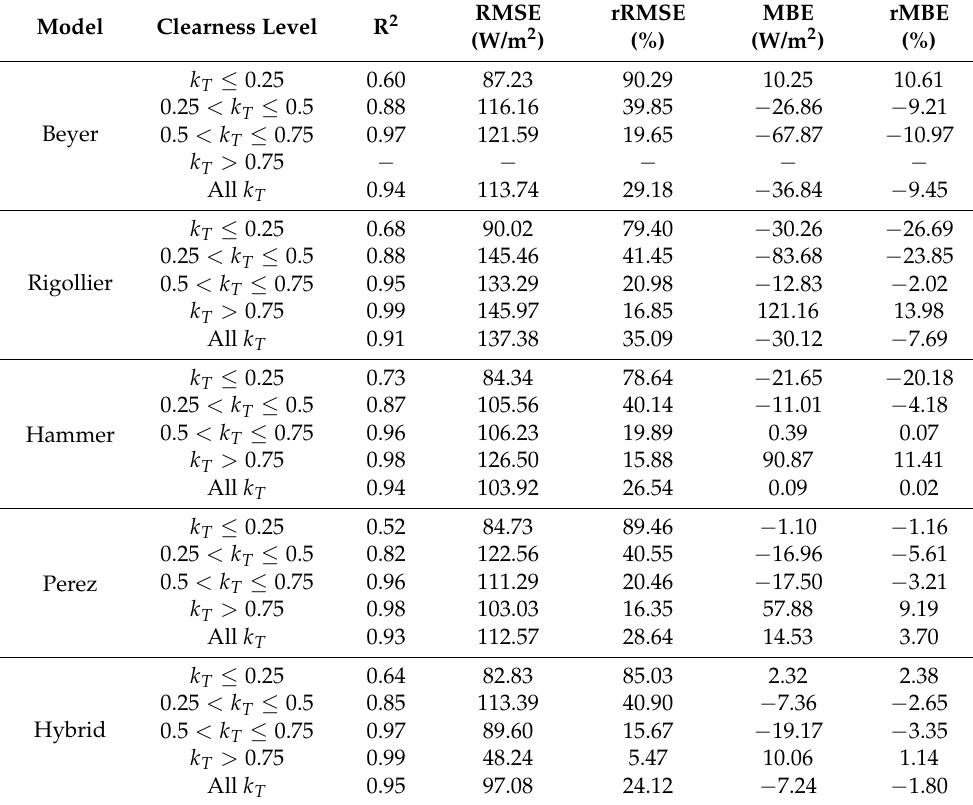
Table 6. Accuracy of the GHI models by level of clearness